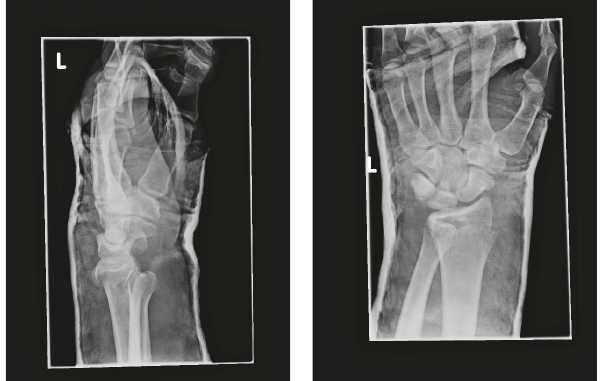
Figure 1: Anteroposterior and lateral X-rays of the affected wrist postimmobilization.